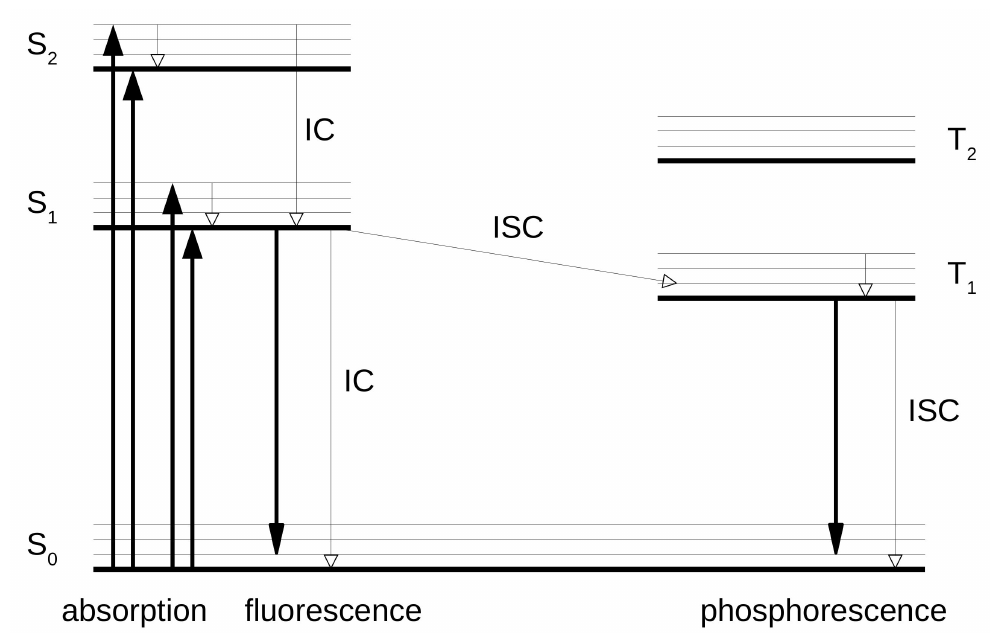
Figure 1. Jablonski diagram, explaining photophysical processes in molecular systems. Empty arrows denote non-radiative transitions: vibrational relaxation, internal conversion (IC) and intersystem crossing (ISC), see